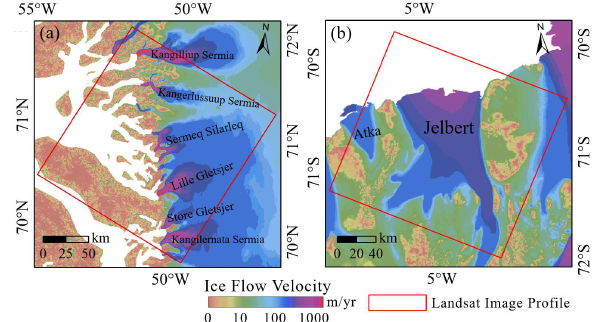
Figure 2. Number of glaciers (ice shelf) contained in one Landsat image. (a) Greenland, Landsat image ID: LM40110101983249KIS00. The ice flow velocity product attached to the images is MEaSUREs Multi-year Greenland Ice Sheet Velocity Mosaic, Version 1 (Joughin et al., 2016). (b) Antarctica, Landsat image ID: LM51761101987288AAA03. The ice flow velocity product attached to the images is MEaSUREs InSAR-Based Antarctica Ice Velocity Map, Version 2 (Rignot et al.,